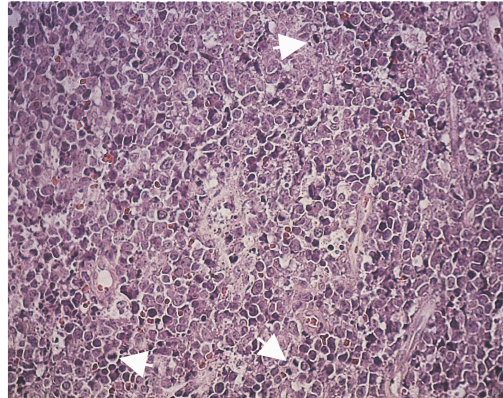
Figure 3: Histological aspect of the specimen revealing a diffuse proliferation of atypical large lymphoid cells, with predominance of centroblasts and high mitotic index (arrows) (HE ×